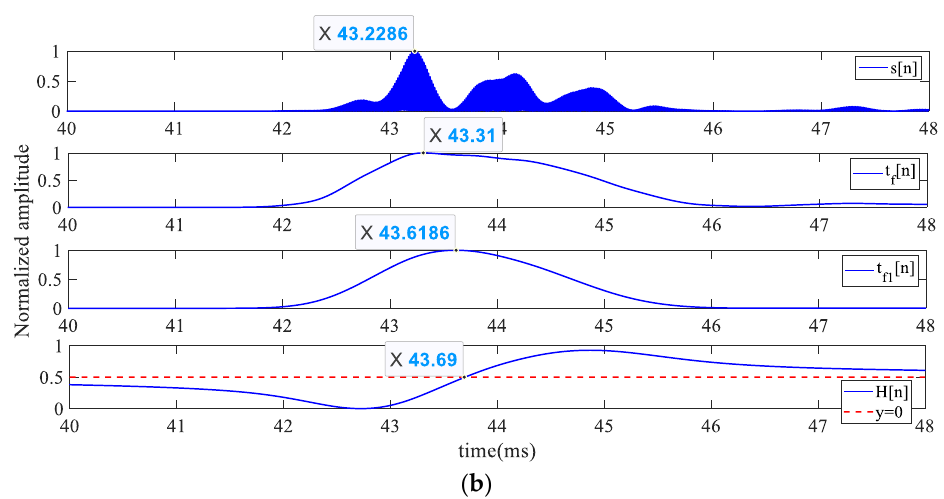
Figure 15. The analysis of peak detection time under test distance equaling to 100 m, ( a ) encoded excitation decoding, ( b ) peak detection.